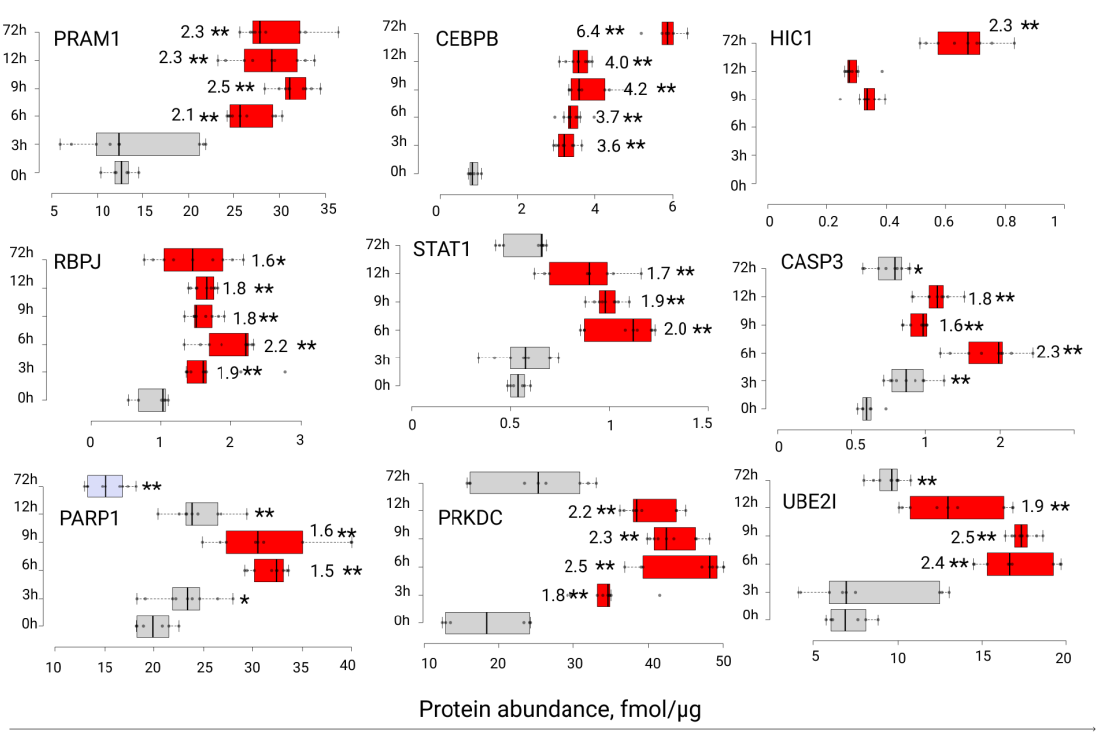
Figure 5. Results of quantitative MRM/SIS analysis of proteins PRAM1, CEBPB, HIC1, RBPJ, STAT1, CASP3, PARP1, PRKDC, and UBC9 in the HL-60 cell nuclear fraction at 0, 3, 6, 9, 12, and 72 h after ATRA treatment. Upregulated, unchanged and downregulated proteins are shown in red, gray, and blue, respectively. One (*) and two asterisks (**) indicate the p -value thresholds of 0.05 and 0.01, respectively. The number of nearby asterisks indicates the protein abundance fold change compared to the control (0 h), except for HIC1 (fold change in protein abundance compared to first time point of detection (9 h)). The x-axis shows the protein abundance in fmol/ µ g. The experimental time points (0, 3, 6, 9, 12, and 72 h) are shown on the y-axis. The proteins were considered as upregulated if the fold change was above